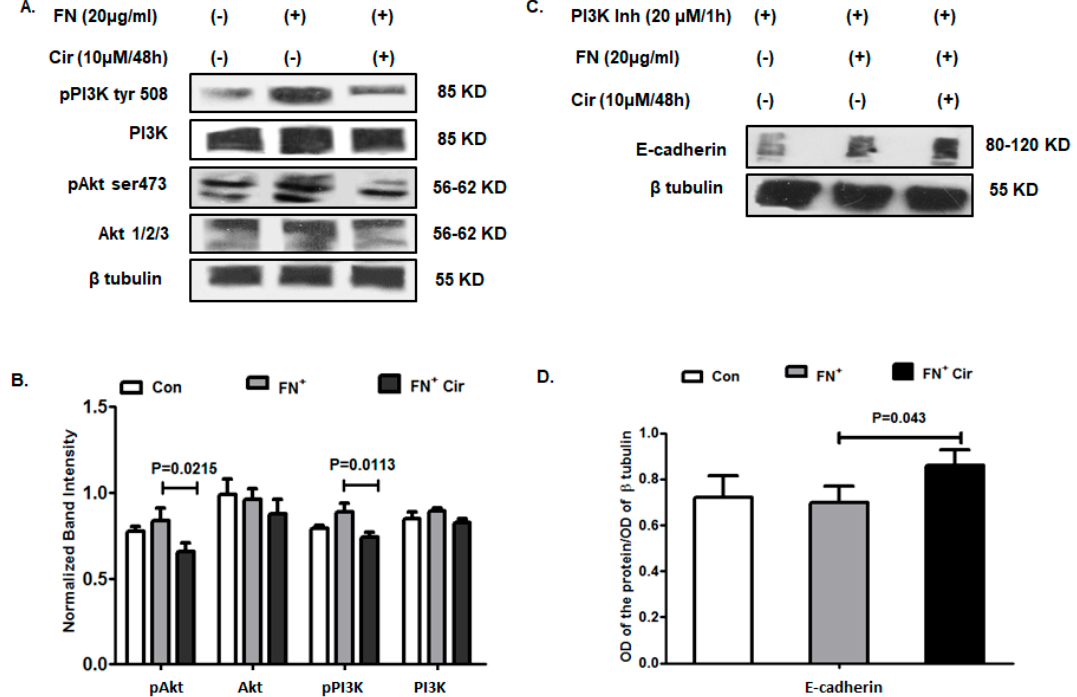
Figure 6. Effect of cirsiliol on regulation of EMT in B16F10 cells. ( A ) Representative images of western blot and ( B ) graphical representation of the normalized band intensities implied reduced phosphorylation status of both PI3Ktyr508 and pAktser473 treatment with FN + /Cir (10 µM/48 h) treated cells than FN + -induced cells. ( C ) Western blot images and ( D ) graphical representation of mean band intensities of the upregulated expression of E-cadherin in the FN + -induced B16F10 cells and FN + /Cir (10 µM/48 h) treated B16F10 cells in comparison to control cells in presence of PI3K inhibitor. Cir: cirsiliol; FN + : cells were seeded in pre-coated (cellular FN 20 µg/mL for 2 h at 37 ° C) petri dishes and further incubated for 48 h in the presence of 5% FBS for induction of EMT; FN + /Cir (10 µM/48 h): cells were seeded in pre-coated (cellular FN 20 µg/mL for 2 h at 37 ° C) petri dishes and treated with subjected to a non-cytotoxic dose of cirsiliol (10 µM) treatment for 48 h. All quantitative results are expressed as mean±SD based on three replicates.